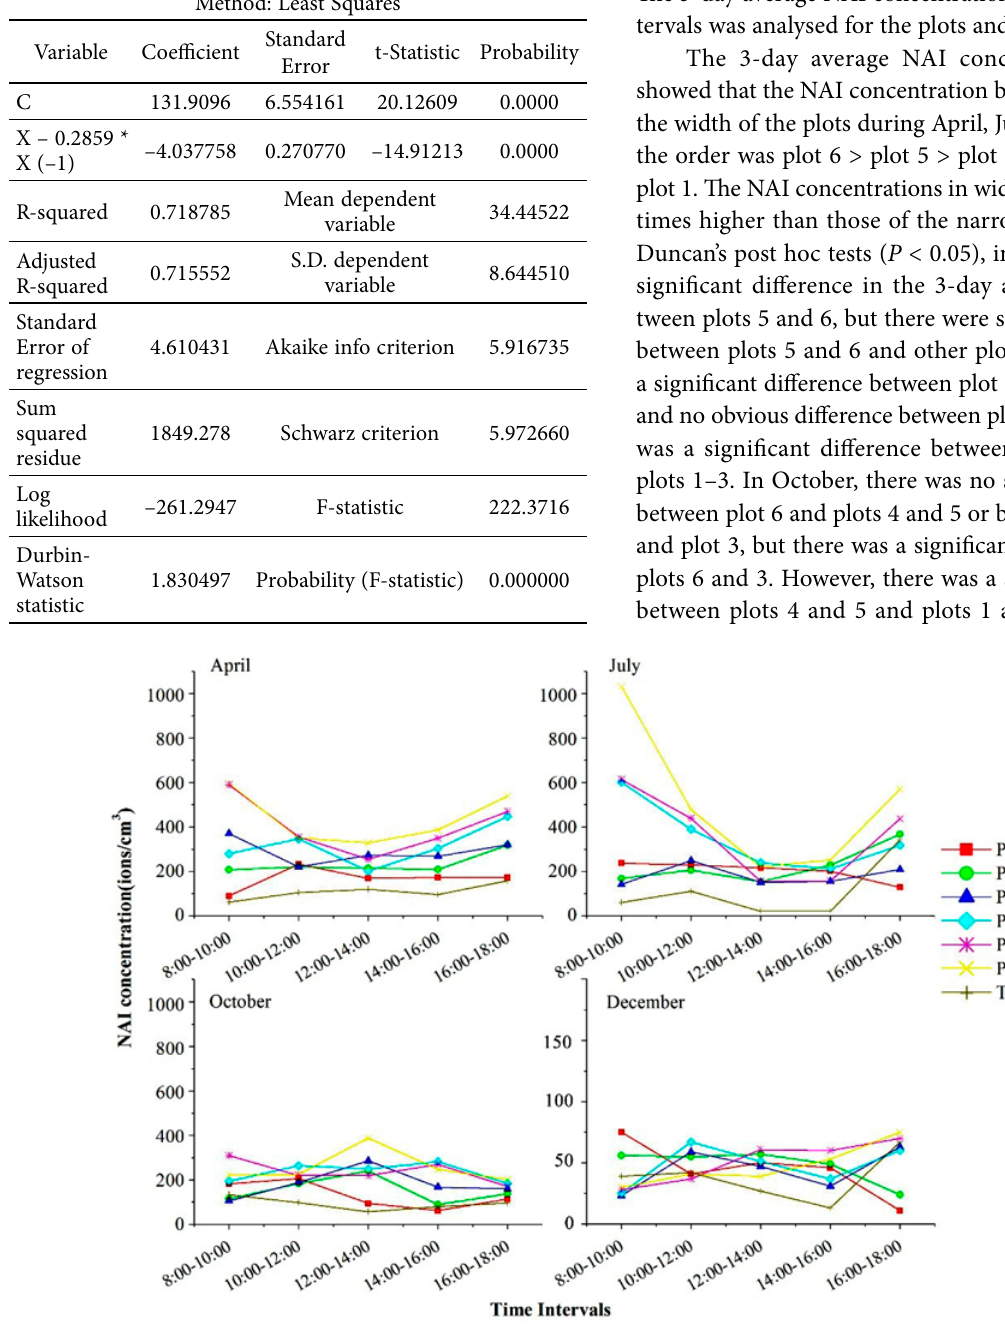
Fig. 10. NAI concentration changes of the green belts over five time